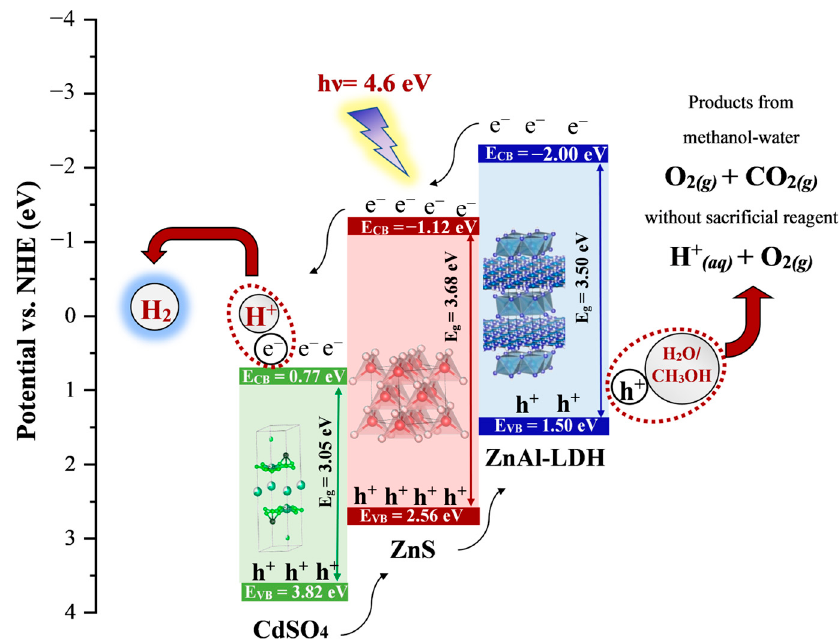
Figure 11. Reaction mechanism for the sample ZAC-100S.